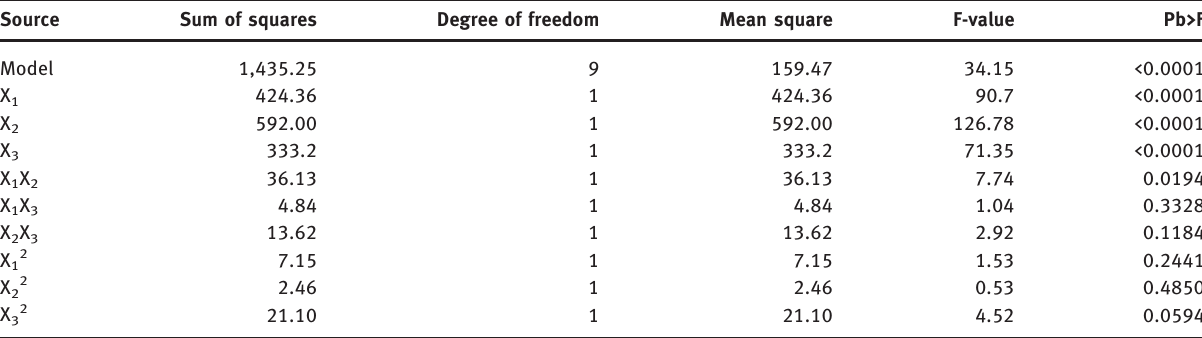
Table 5: Analysis of variance for the yield. Source